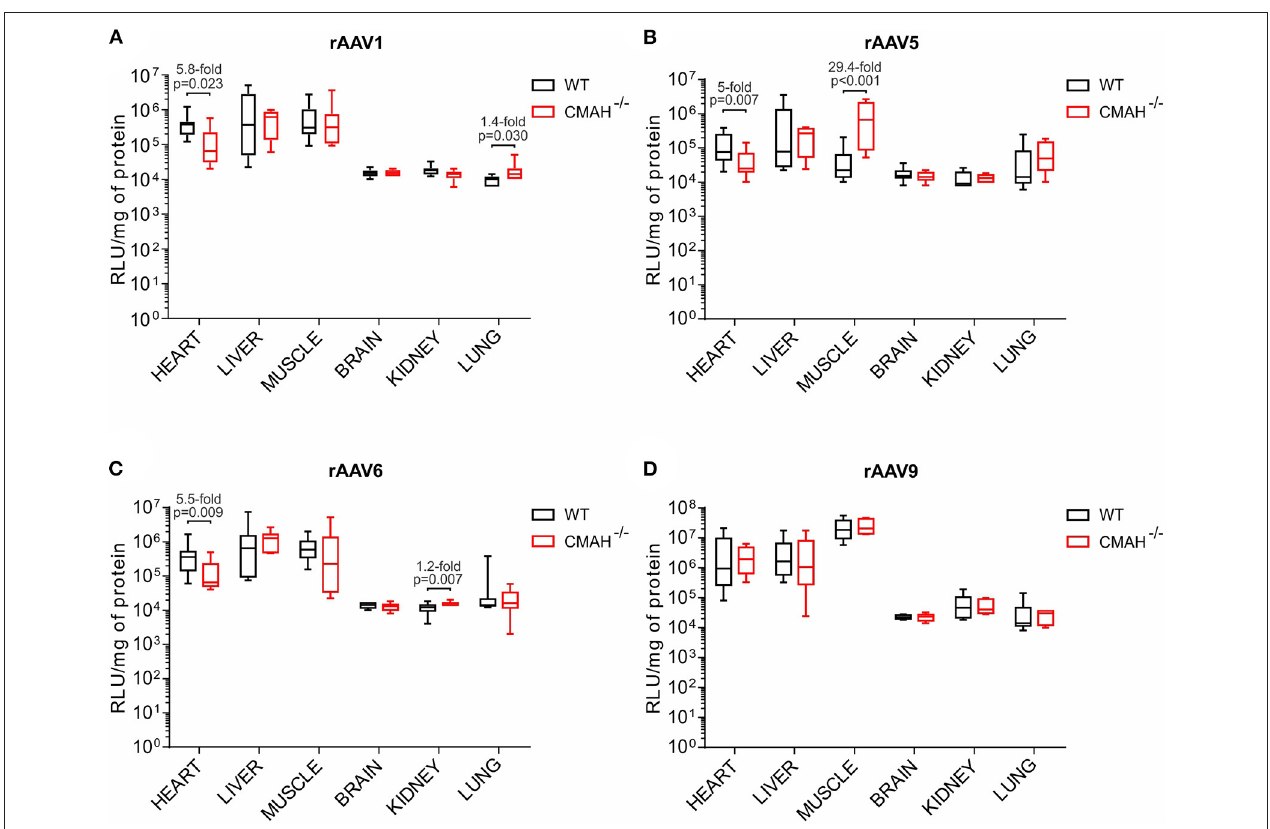
FIGURE 2 | Transduction efficiencies of AAV1, AAV5, AAV6, and AAV9 in wild-type C57BL/6J (WT) and CMAH knockout (CMAH − / − ) mice. WT ( n = 8-10) or CMAH − / − ( n = 9-10) mice were tail vein injected with 3 × 10 11 vg of rAAV1-Luc (A) , rAAV5-Luc (B) , rAAV6-Luc (C) , or rAAV9-Luc (D) . One month post vector administration, luciferase activity and protein content were determined in each organ as described in the Materials and Methods section. Luciferase activity values were normalized to total protein content and expressed as relative light units (RLU)/mg of protein. Boxes correspond to upper and lower quartiles, the horizontal line represents the median, and the whiskers mark the minimum and maximum values. P -values among the groups are indicated. The Mann-Whitney test was applied for statistical